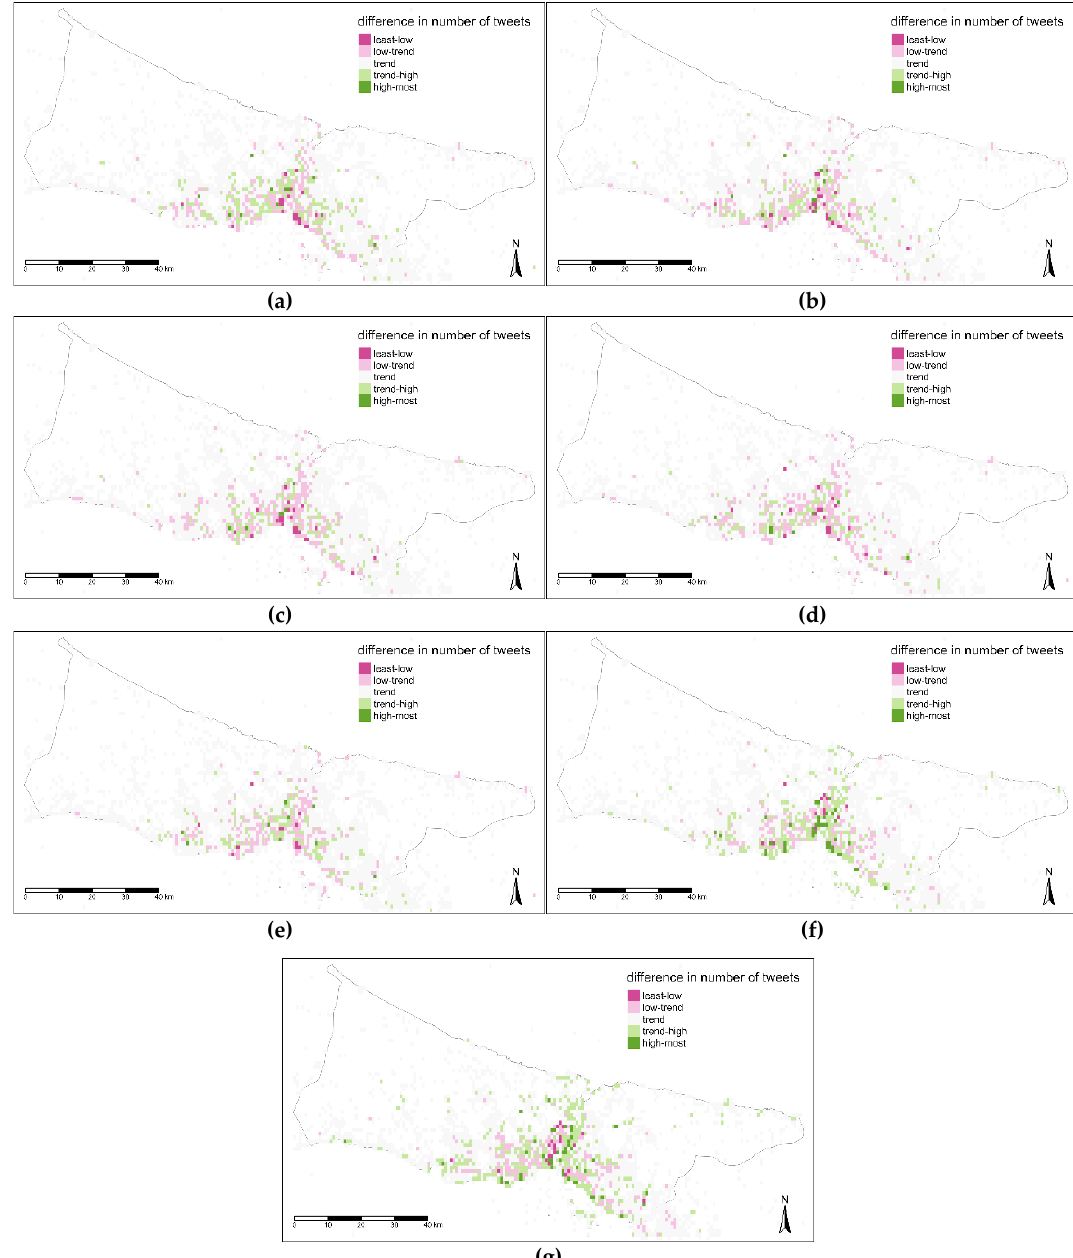
Figure 15. Spatiotemporal Bias for Temporal Level-2 ( a ) Monday; ( b ) Tuesday; ( c ) Wednesday; ( d ) Thursday; ( e ) Friday; ( f ) Saturday; ( g ) Sunday.